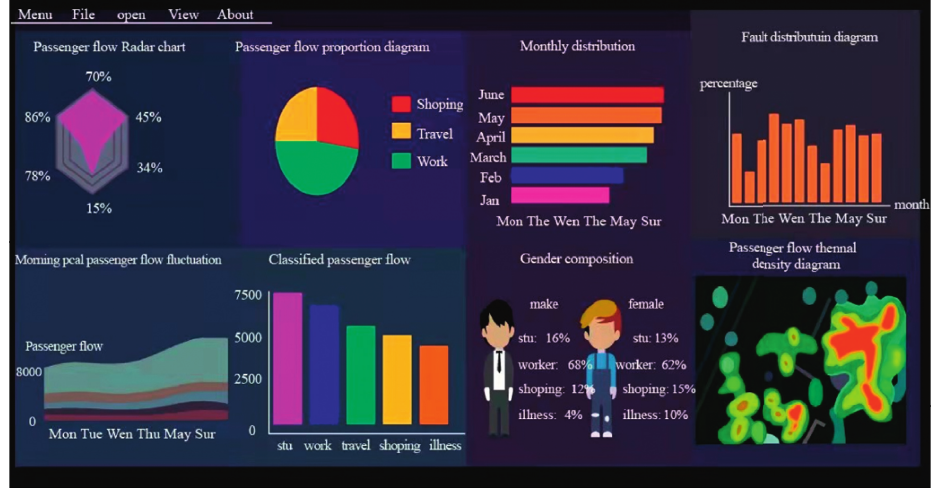
Figure 2: Data acquisition architecture and software